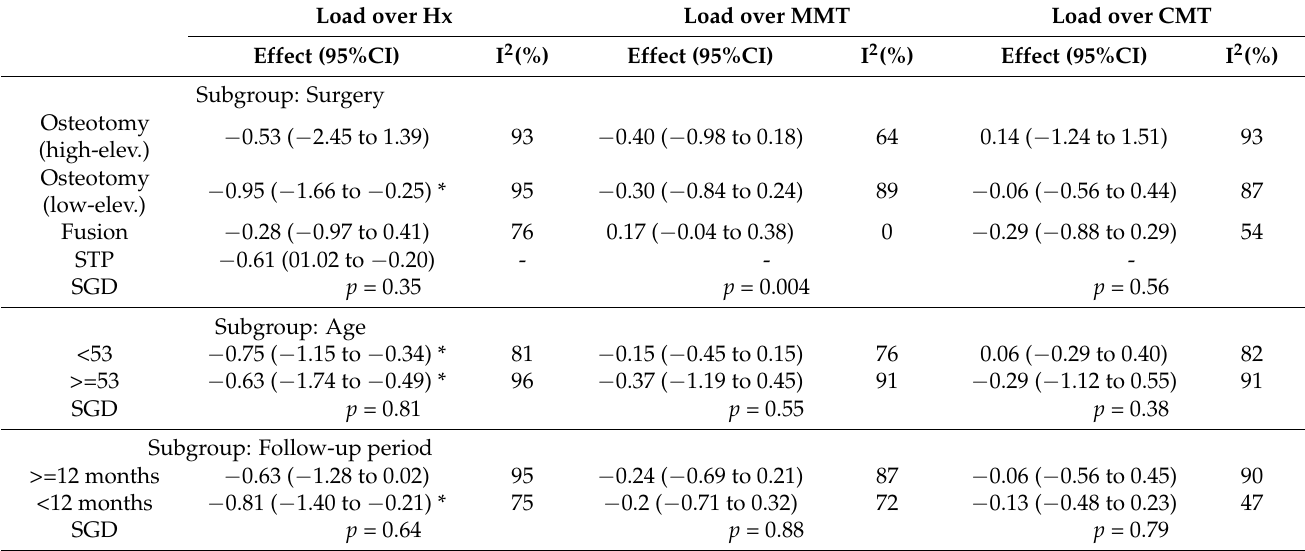
Figure 5. Meta-analysis on the overall effects of surgeries on plantar load over central metatarsal region (decrease means better) [25,32–35,35–38,41,42,44,46,49,50,53,54]. Table 3. Subgroup and sensitivity analysis of the meta-analysis on load